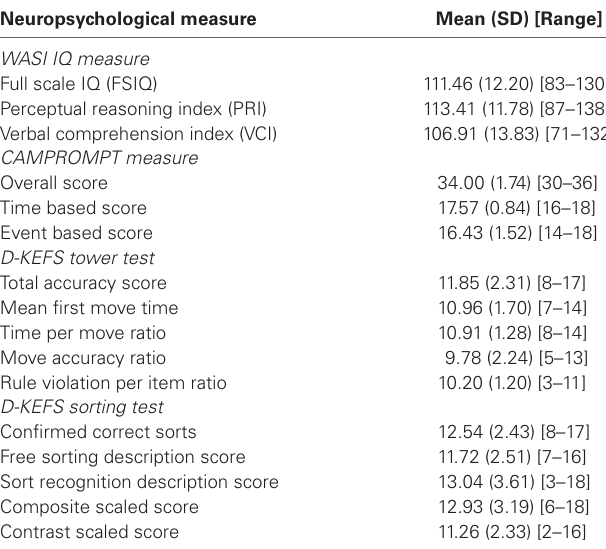
Table 2 | Mean (SD) and [Range] values for standardized neuropsychological test variables ( N = 46) . Neuropsychological